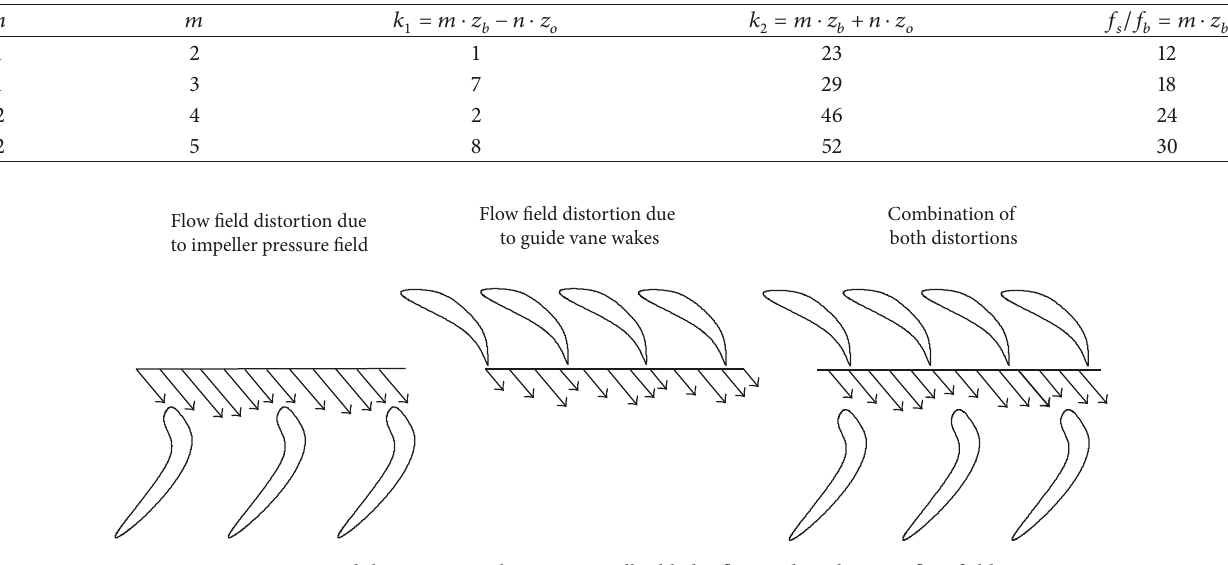
Figure 3: Modulation process between impeller blades flow and guide vanes flow